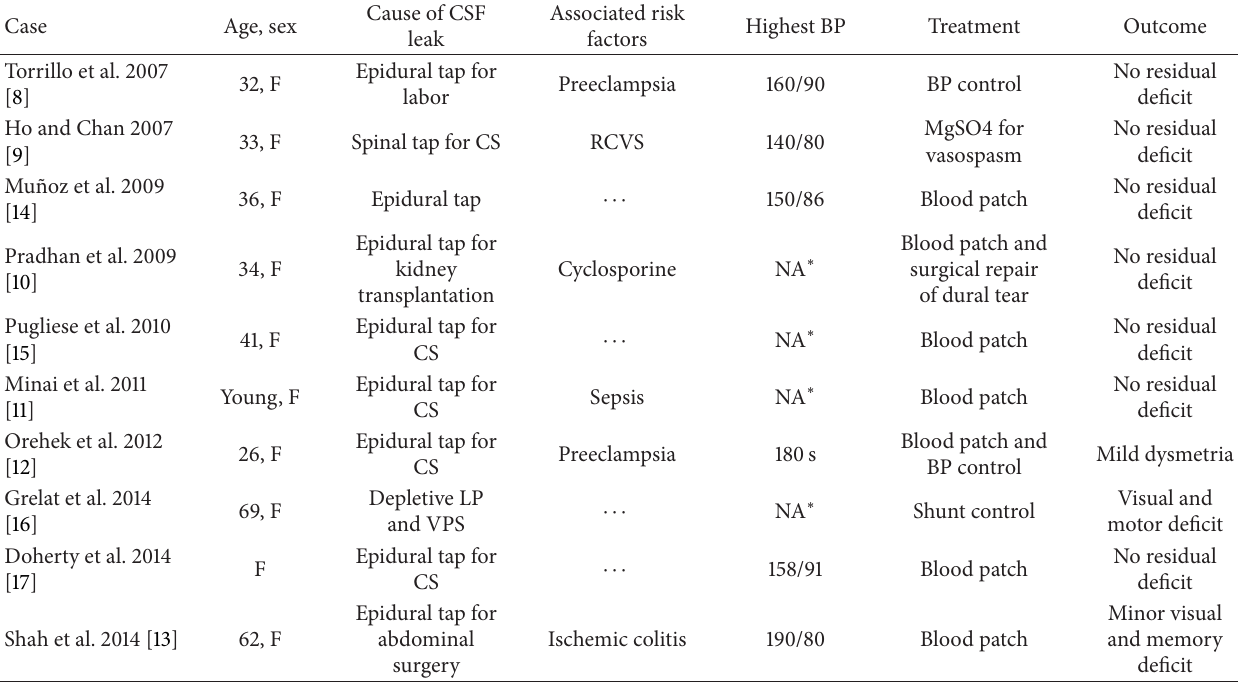
Table 1: This table shows the reported cases in the literature of PRES in the setting of CSF leak. Cause of CSF Associated risk Case Age, sex Highest leak factors